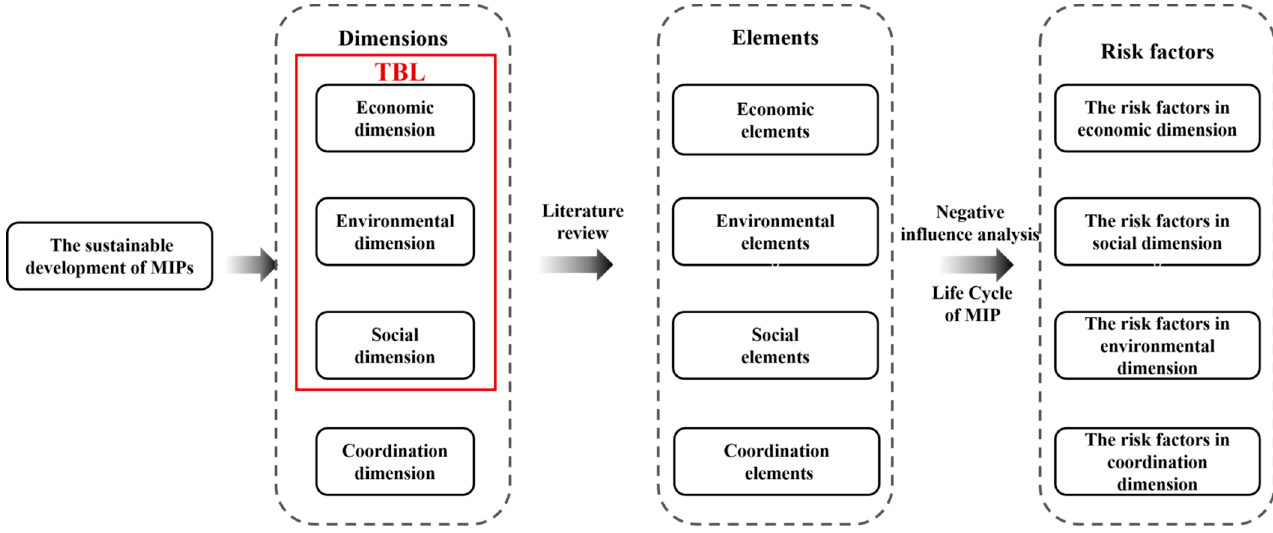
Figure 2. The risk identification conceptual model. Note: MIPs: Mega Infrastructure Projects; TBL: Triple Bottom Line.